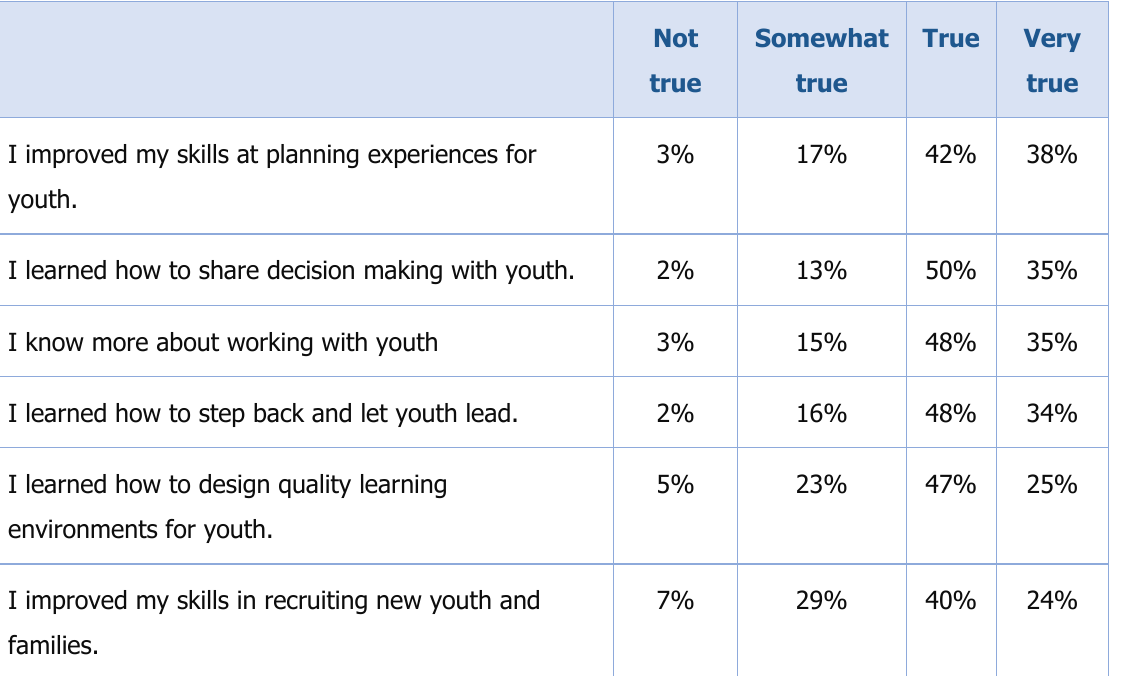
Not Somewhat True Very true true